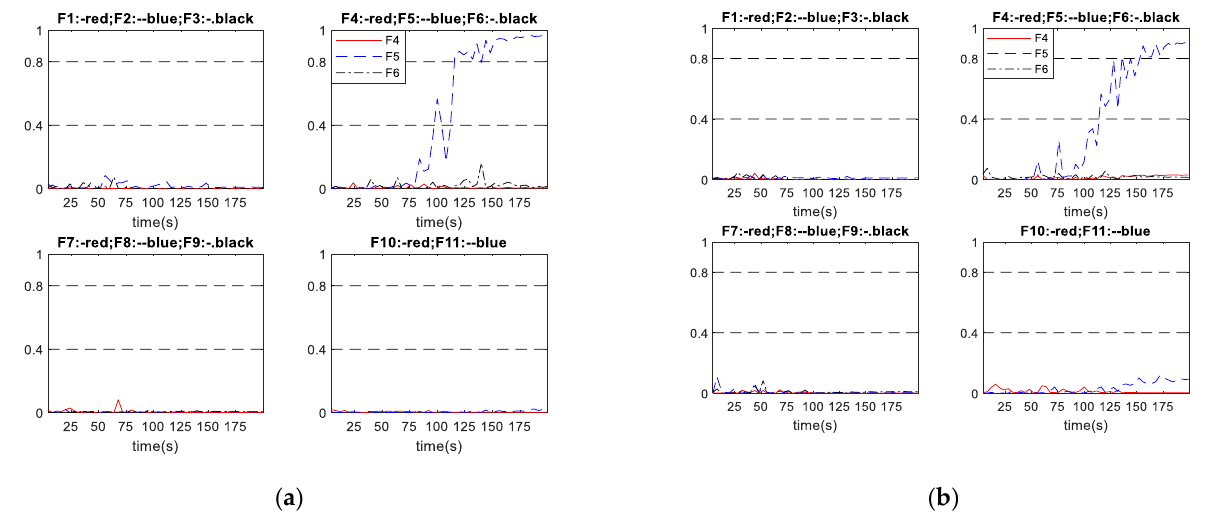
Figure 11. Diagnosis performance of scheme A ( a ) and scheme B ( b ) under incipient fault No. 5 with developing speed of 1.12 × 10 −4 (s −1 ).